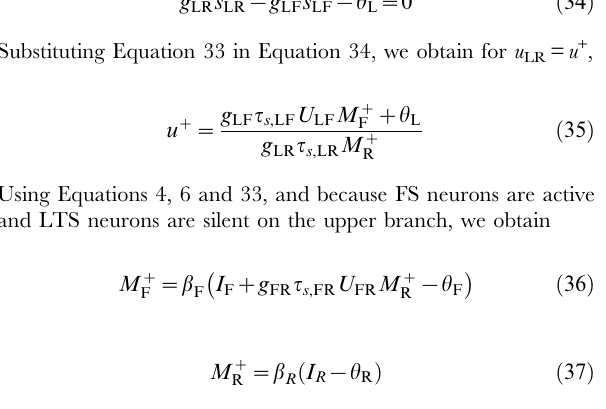
Figure S2 Steady-state response of the RS-LTS network with RS-to-RS synaptic connections to constant inputs to the RS neurons. Additional parameters are g RL =35, g LR = 7.5. Solid lines denote stable states, and dashed lines denote unstable states. (A) M R - I R curves (top panel) and M L - I R curves (bottom panel) are plotted for g RR = 0 (black), 20 (red), 40 (green) and 60 (blue). Additional parameter is t r ,RR =463 ms. The values of M R,c for g RR = 40 and 60 are denoted by solid circles. (B) M R - I R curves are plotted for t r .RR = 0 (black), 60 ms (red), 200 ms (green), 463 ms (blue) and 1000 ms (yellow). Additional parameter is g RR = 40. Figure S3 Response of the RS-LTS network with RS-to- RS synaptic connections to step inputs I R H ( t ) to the RS neurons. Time courses of M R (top panel) and M L (bottom panel) are shown. Additional parameters are g RL =35, g LR